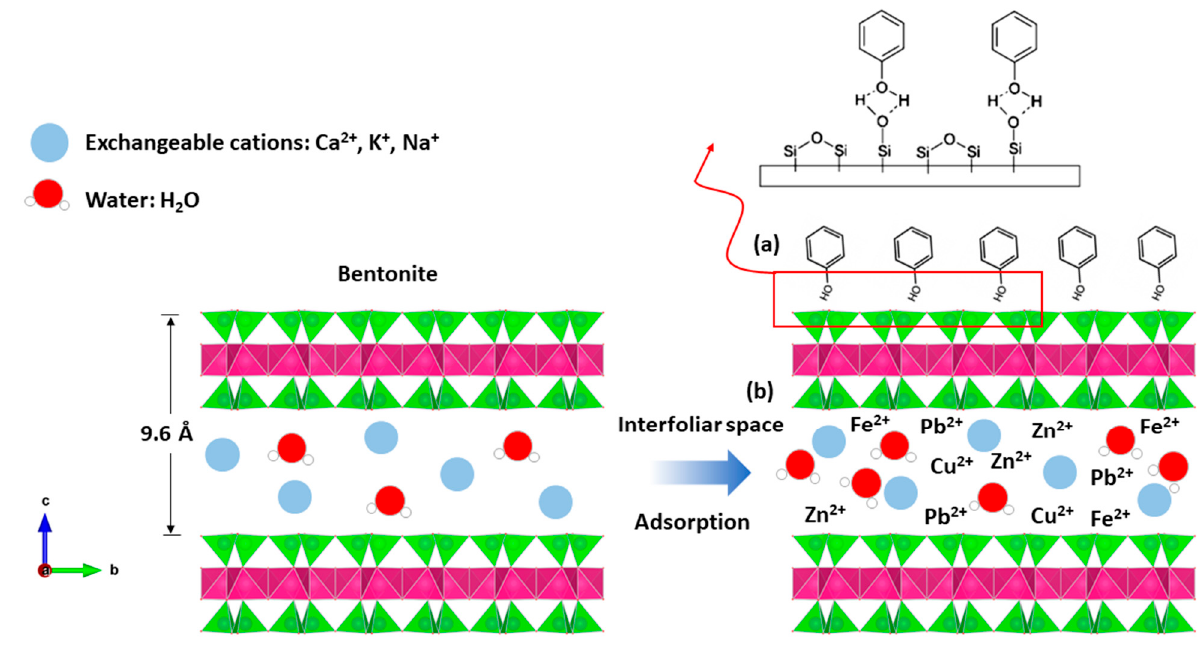
Figure 12. Adsorption mechanism between; ( a ) phenol and bentonite; ( b ) heavy metal and bentonite.